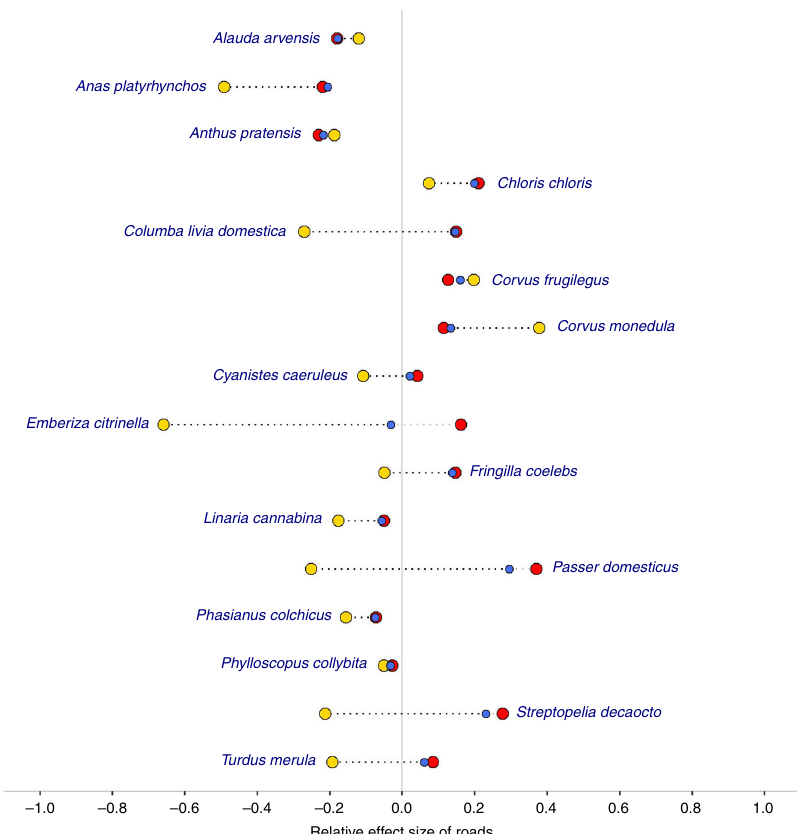
Fig. 5 Relative effect size of associations between bird abundance and exposure to different road types. As in Fig. 1, the relative effect size was calculated as a composite of the magnitude of the effect size of road exposure and the spatial scale over which the effect could be detected. Associations with major roads are shown in yellow, minor roads in red and both road types together in blue. Only species with signi fi cant associations for all three road categories, determined using a critical alpha level of 0.05 without Bonferroni correction, are featured here.